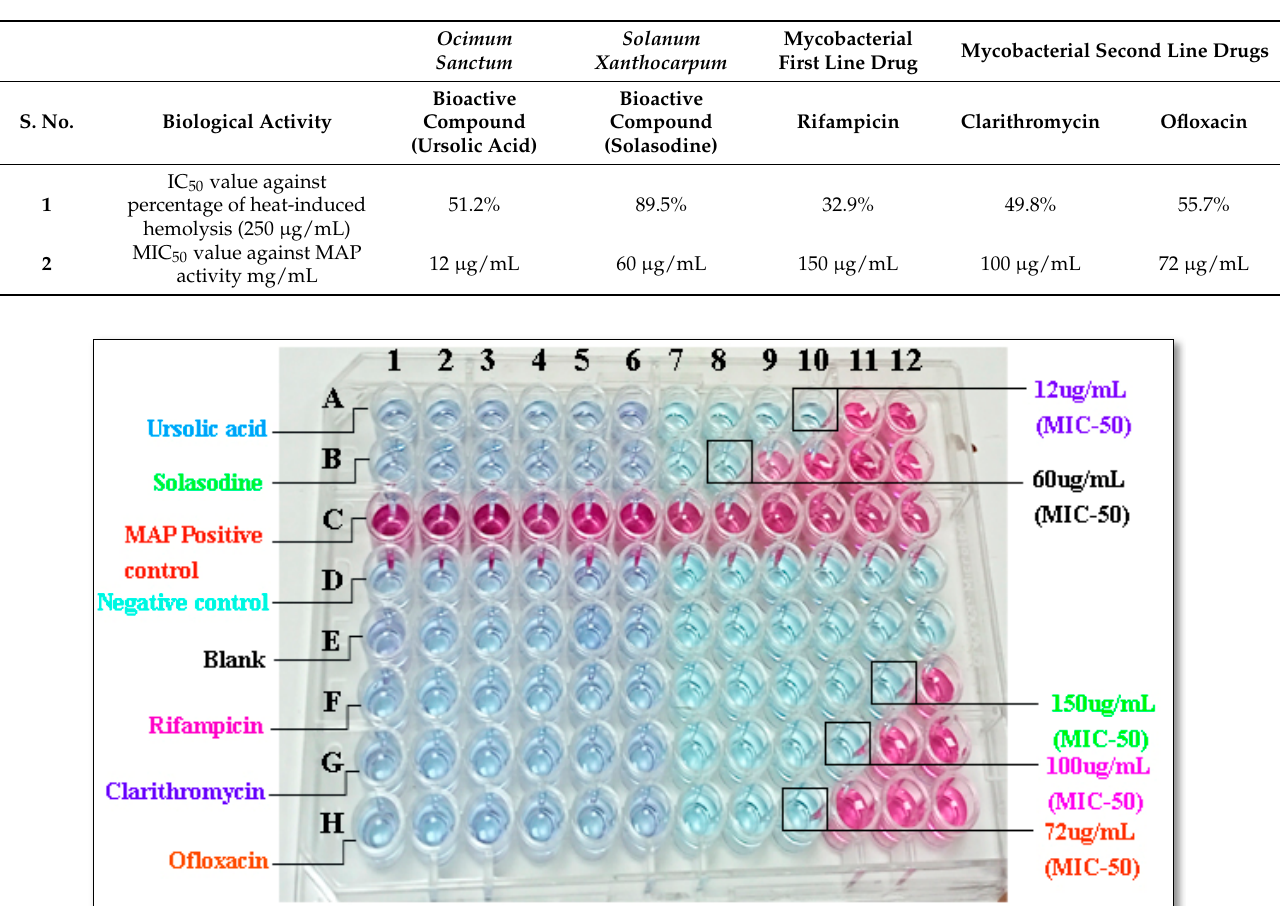
Table 1. In vitro analysis of bioactive compounds (Ursolic acid and Solasodine) of Ocimum sanctum and Solanum xanthocarpum using control as a standard and an anti-mycobacterial first-line drug (Rifampicin) and second-line drugs (Clarithromycin and Ofloxacin).